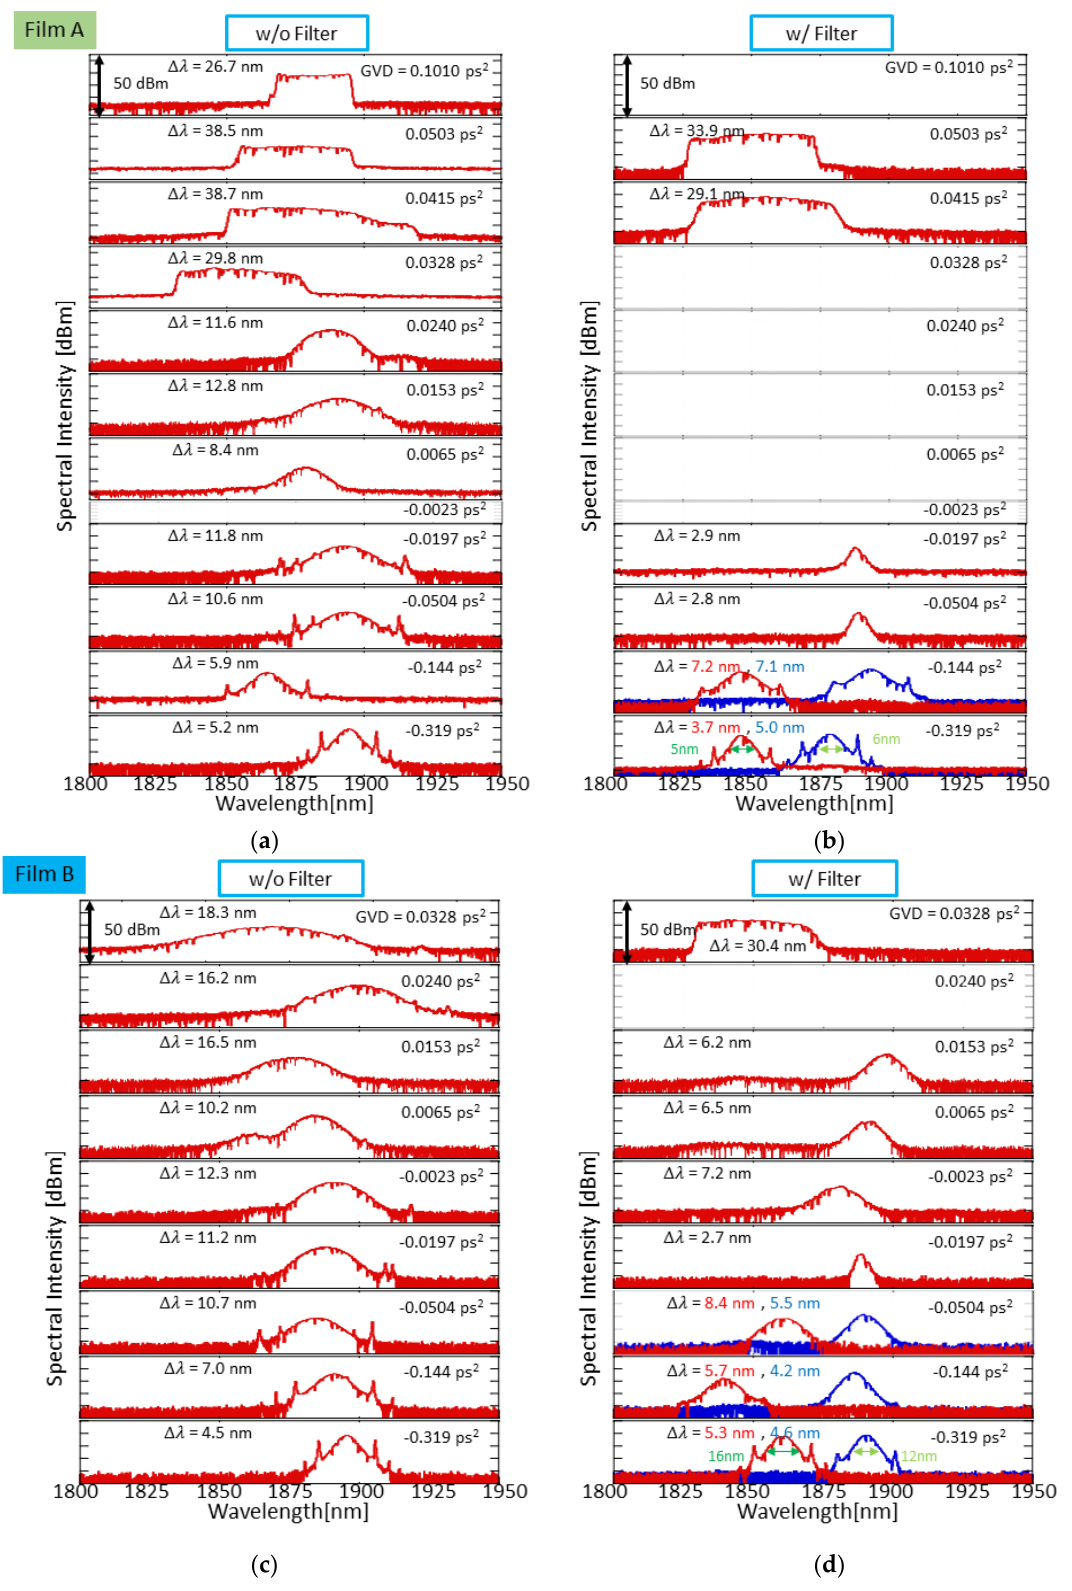
Figure 4. Variation of optical spectra at fiber laser output when net dispersion was varied. ( a , b ) film A was used and spectral filter was ( a ) not used and ( b ) used. ( c , d ) film B was used and spectral filter was ( c ) not used and ( d ) used.